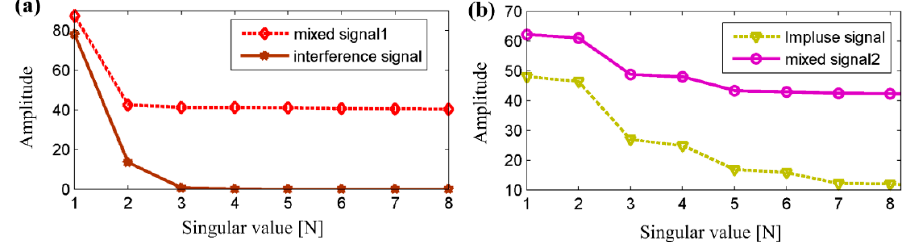
Figure 7. The singular components. ( a ) The interference signal and mixed signal 1; ( b ) The impulse signal and mixed signal 2.